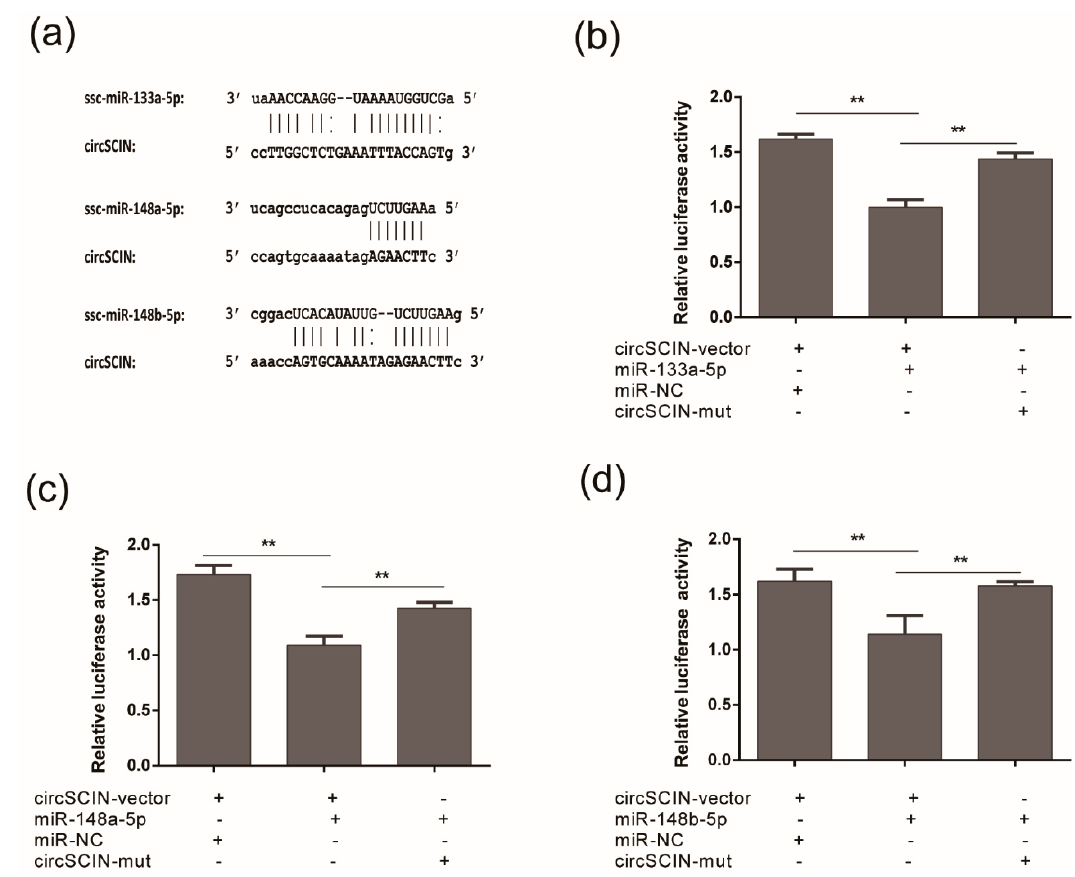
Figure 4. CircSCIN sponged with miR-133a and miR-148a/b. ( a ) The predicted miR-133a-5p, miR-148a-5p, and miR-148b-5p binding sites at three distinct positions in circSCIN. ( b ), ( c ), ( d ) Luciferase reporter assay revealed that miR-133a, miR-148a, and miR-148b were able to reduce the luciferase activity. "+" and "-" in (b), (c), and (d) represented circSCIN-vector, miRNA mimic, miR-NC and circSCIN-mut was transfected into HEK 293T cells or not, respectively. Data in (b), (c), and (d) were the means ± s.e.m for relative luciferase activity. **, p ≤ 0.01 (Student's t-test).